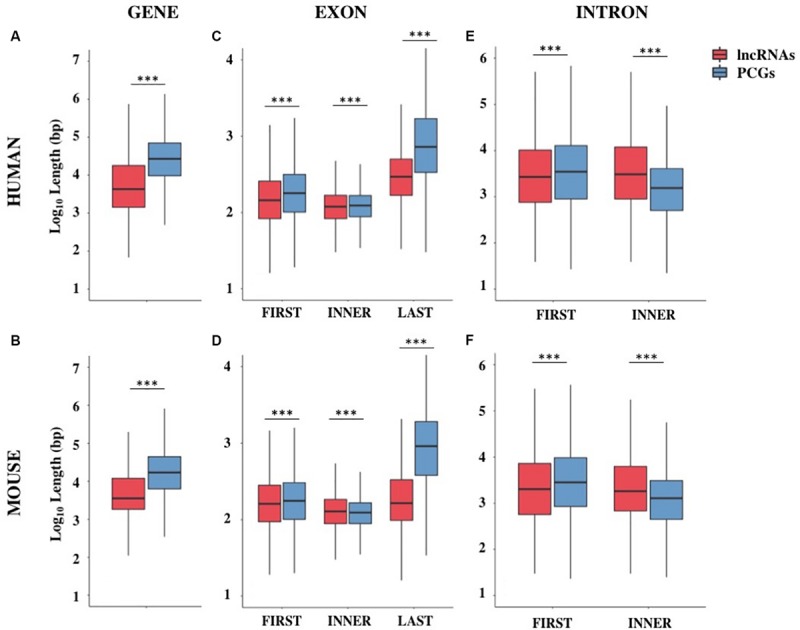
Gene structure features of long non-coding and protein-coding genes (PCGs) in human and mouse. Boxplots showing the gene length (A,B), exon length (C,D), and intron length (E,F) in human and mouse, respectively. Data were presented as log10 of length in base pairs (bp). Exons were classified as first, inner or last and introns were classified as first or inner. ***p < 0.001.